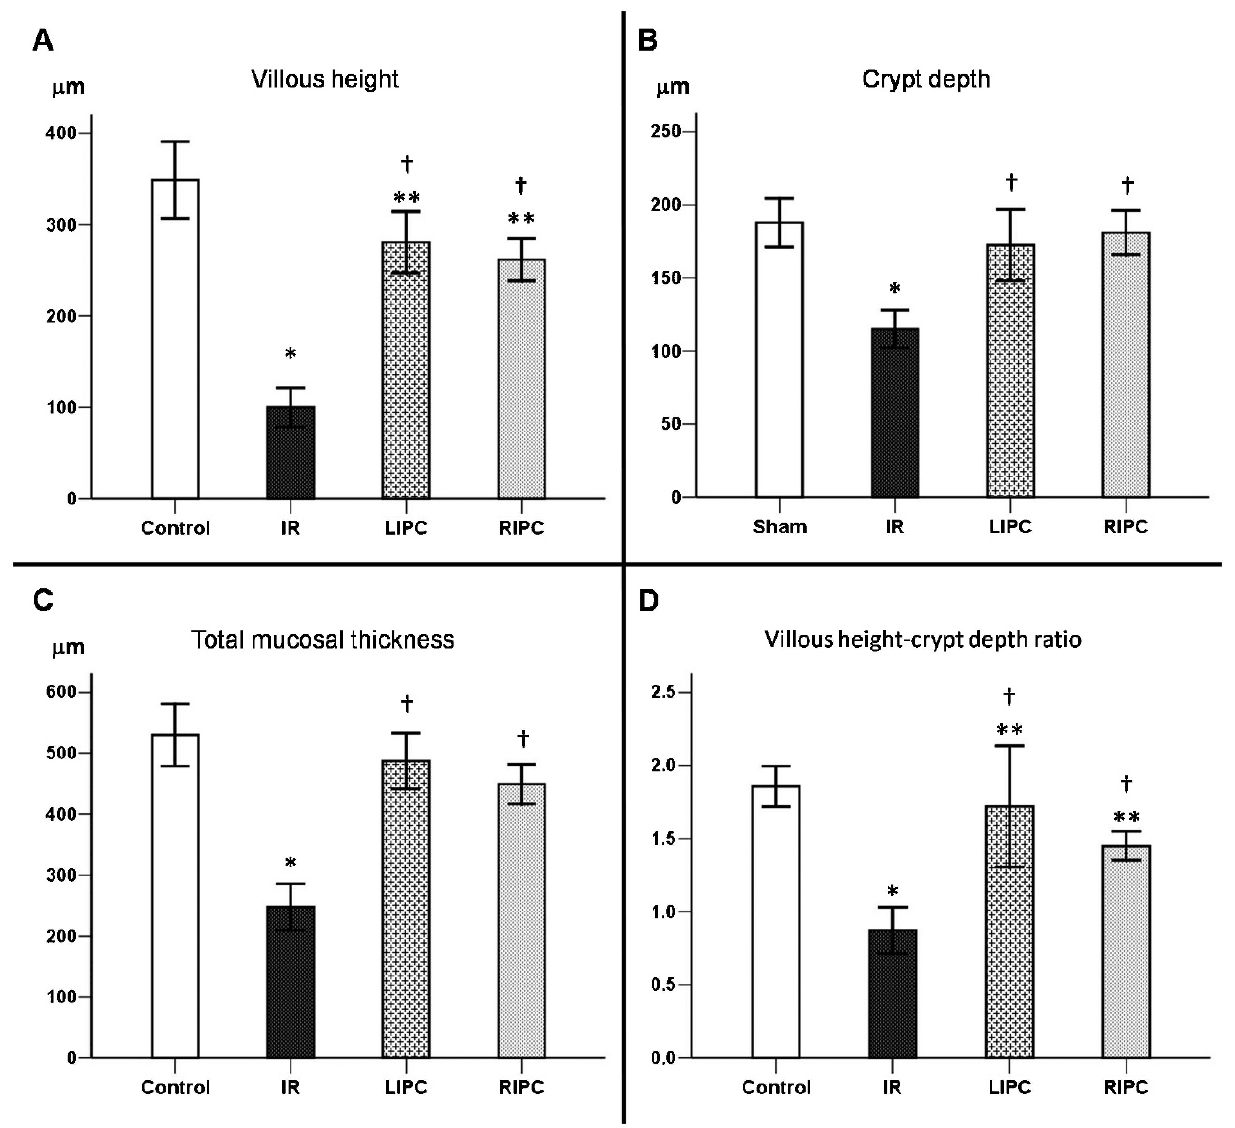
Figure 2 - Histomorphometric analysis of the small bowel demonstrating villous height (A), crypt depth (B), total mucosal thickness (C), and villous height-crypt depth ratio (D) in the control, ischemia and reperfusion (IR), local ischemic preconditioning (LIPC), and remote ischemic preconditioning (RIPC) groups. Data are expressed as the mean ¡ SE for 7 animals per group. (*) p , 0.001: IR vs . control, (**) p , 0.05: LIPC and RIPC vs . control, ( { ) p , 0.001: LIPC and RIPC vs